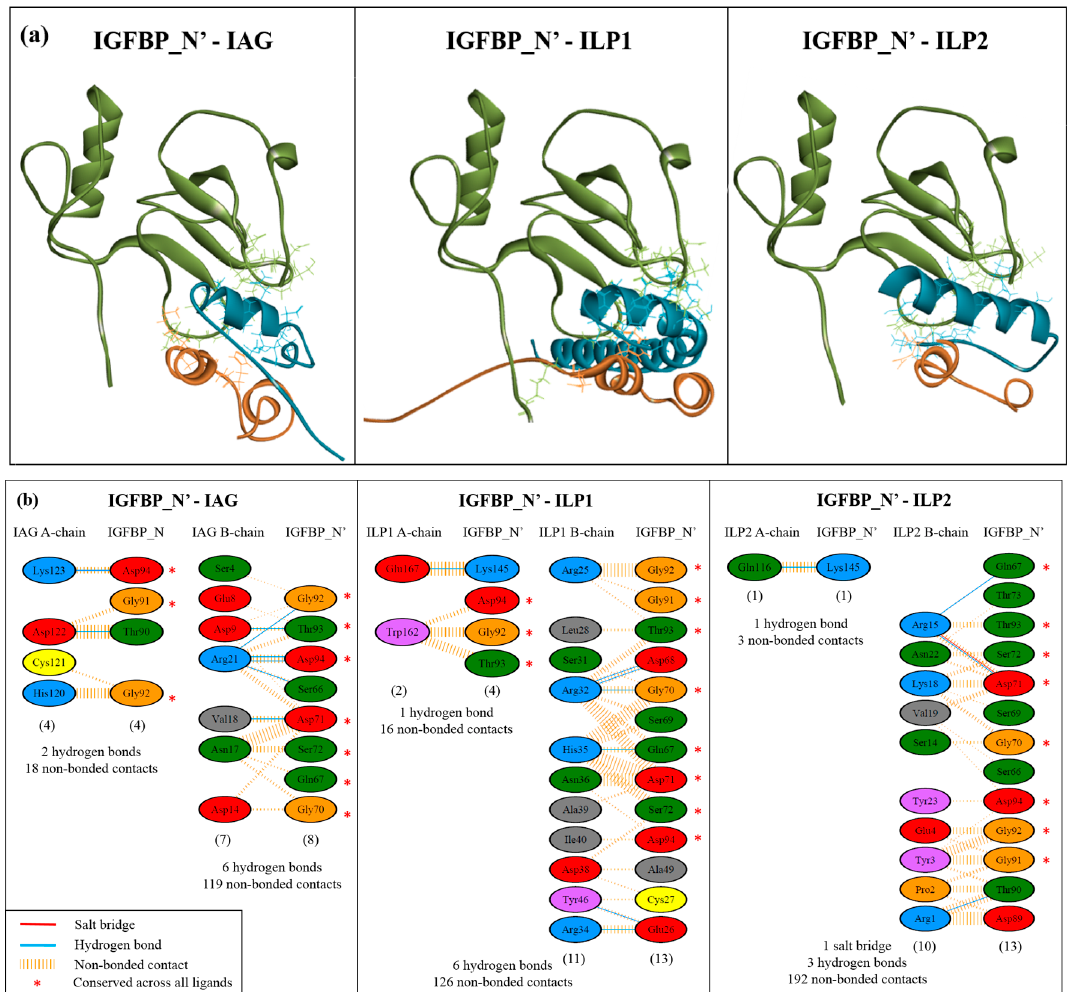
Figure 5. Molecular structure models of bound complexes and interaction map: ( a ) Complex of Sv-IGFBP_N’ with each ligand. In each case the IGFBP_N’ is in green and the ligand in orange (A-chain) and blue (B-chain). All residues involved at the binding interface are indicated in stick, with colouring as previously described. ( b ) Interaction map describing residue-specific interactions between Sv-IGFBP_N’ and each ligand. Standard amino acid abbreviations are used, with colours indicating physicochemical properties as follows: blue—positive, red—negative, green—neutral, grey—aliphatic, mauve—aromatic, orange—proline and glycine, and yellow—cysteine. Number of interacting residues is given in brackets; an asterisk denotes those residues that show a conserved binding interaction with all three ligands (n = 8).